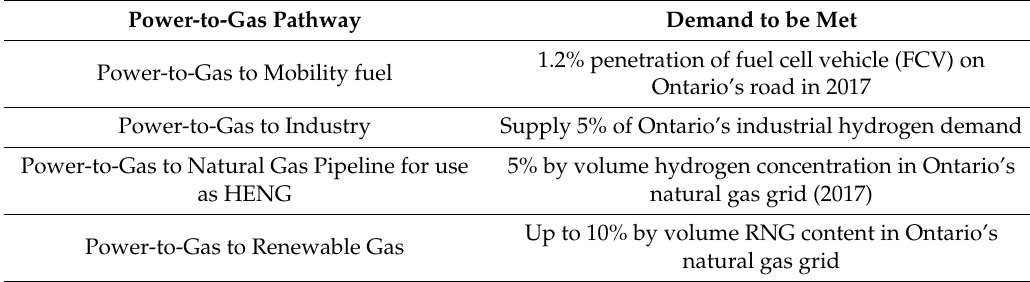
Table 5. Hydrogen, hydrogen-enriched natural gas (HENG), and RNG demand to be met by PtG pathways.